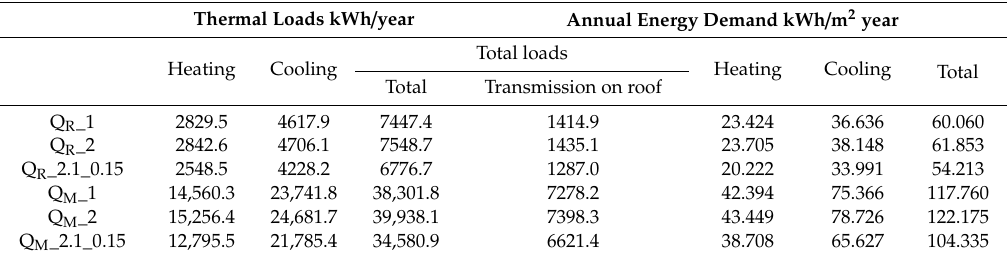
Table 15. Summary of thermal loads, loss or heat gain of the loft flat and the MUA Sempere Hall. Annual energy demand by simulation for the whole 2014